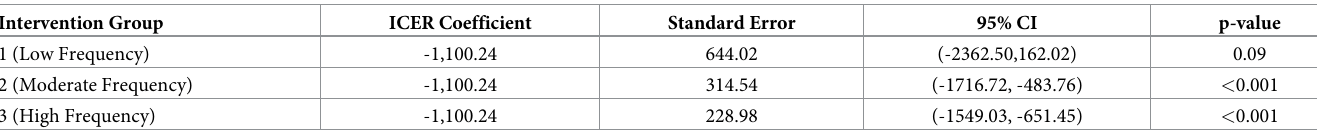
Table 4. Bootstrap analysis of Incremental Cost Effectiveness Ratios (ICERs). Intervention